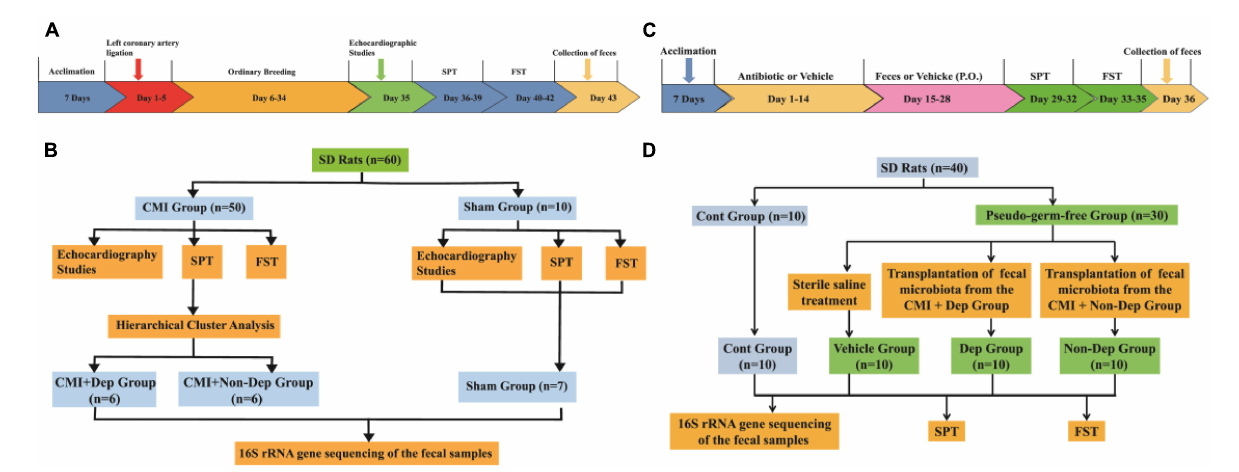
FIGURE 1 | Experimental schedule. (A) The timeline of the first experiment. After acclimation, left coronary artery ligation was performed and then CMI models established after 4 weeks. Cardiac function was evaluated on day 35. SPT was performed on days 36–39. FST was performed on days 40–42. Fecal samples were collected on day 43. (B) The flow chart of the first experiment. Fifty male SD rats were randomly used to establish the CMI models and 10 to the sham models. (C) The timeline of the second experiment. After being acclimated to a new environment for 7 days, rats were randomly treated by giving them large doses of antibiotic solution for 14 consecutive days (days 1–14). Then, pseudo-germ-free rats were orally treated with fecal microbiota from CMI + Dep or CMI + Non-Dep group rats from days 15 to 28. Subsequently, SPT was measured on days 29–32. FST was performed on days 33–35. Fecal samples were collected for 16S rRNA gene sequencing testing on day 36. (D) The flow chart of the second experiment. Thirty male SD rats were randomly used to establish pseudo-germ-free rat models and 10 to the control group. Then the 30 pseudo-germ-free rats were randomly assigned to fecal microbiota transplantation. The fecal microbiota for transplantation was collected from the rats of the CMI + Dep and CMI + Non-Dep groups. CMI, chronic myocardial infarction; SPT, sucrose preference test; FST, forced swimming test; Dep, depression-like behavior; Non-Dep, non-depression-like